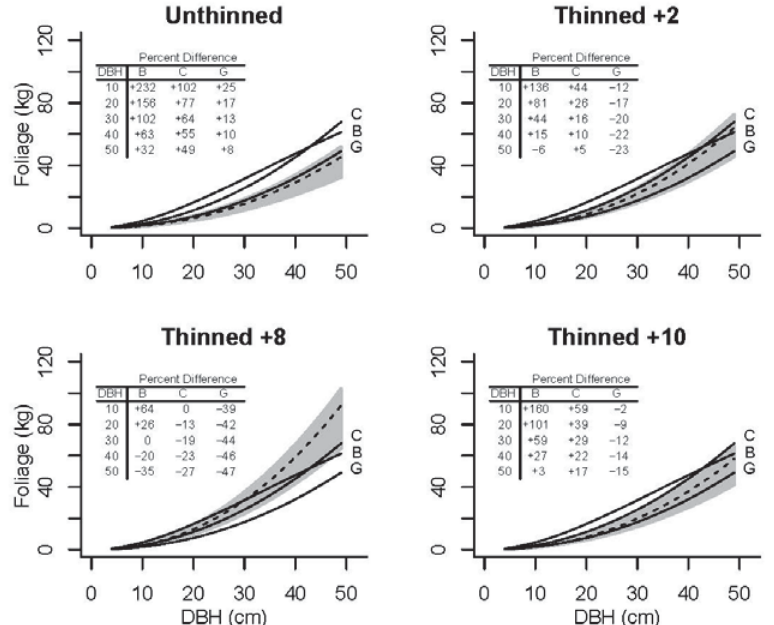
Figure 5. Foliage biomass at Blacks Mountain Experimental Forest (BMEF) with crown ratio (shaded from 0.45 to 0.85) and without crown ratio (dashed line) compared to three published functions (solid lines B, C, G) from [14], [13], and [12]; percent differences from fitted are tabulated by